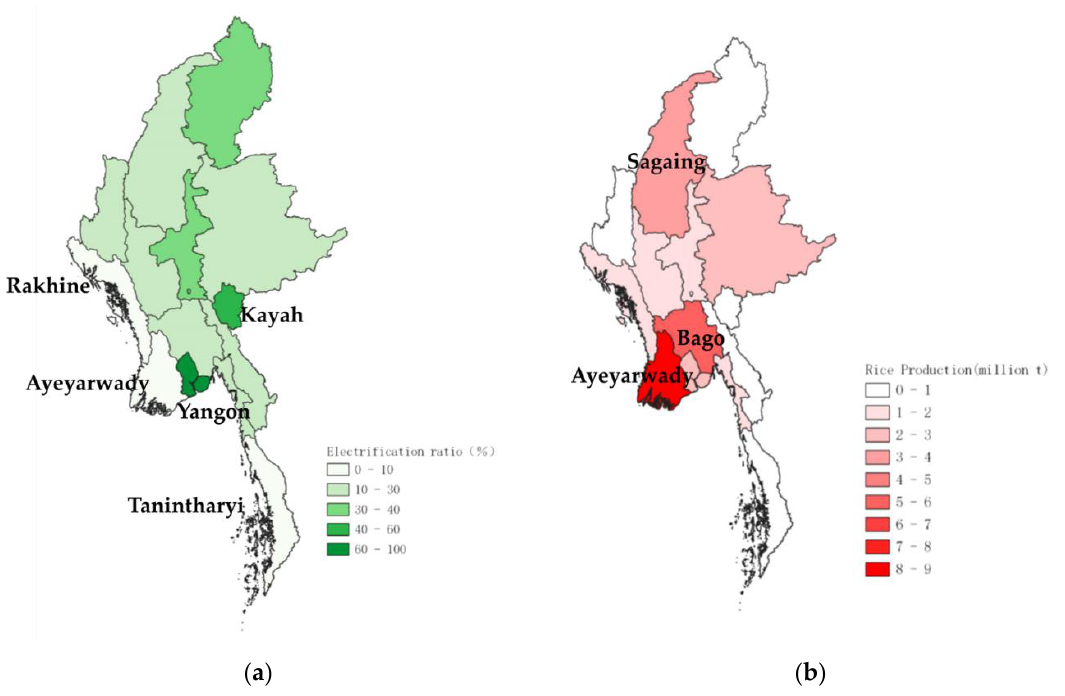
Figure 2. Electrification rate and levels of rice production in Myanmar. ( a ) Electrification ratio of household; ( b ) Production volume of paddy in each district of Myanmar.